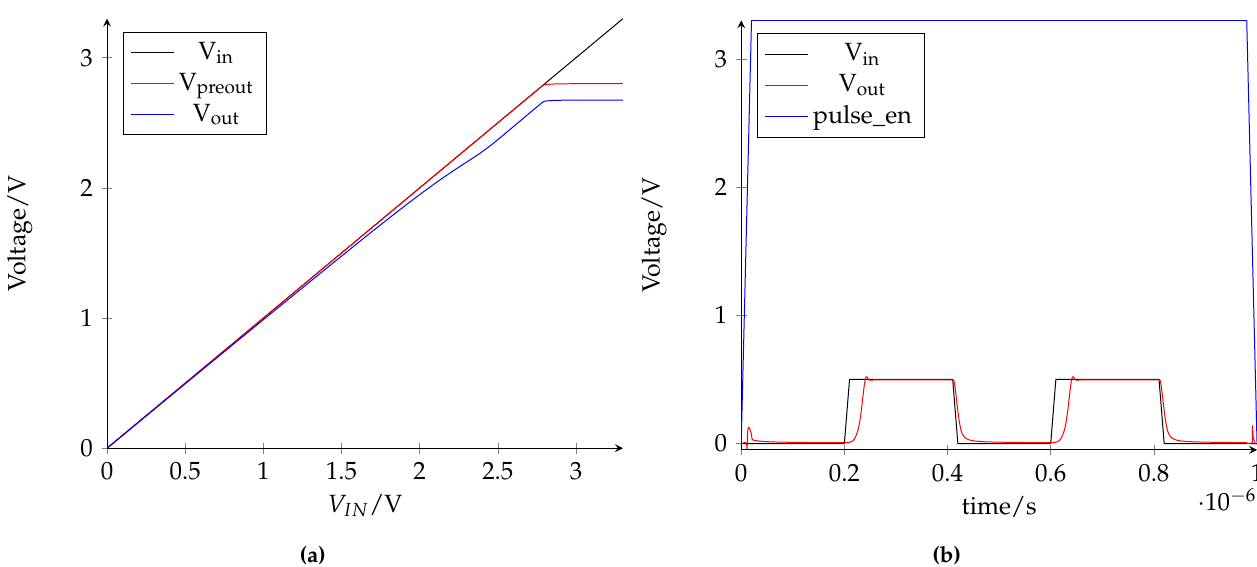
Figure 7. Simulation results of operational amplifier: ( a ): DC sweep of input voltage; ( b ): transient simulation of read